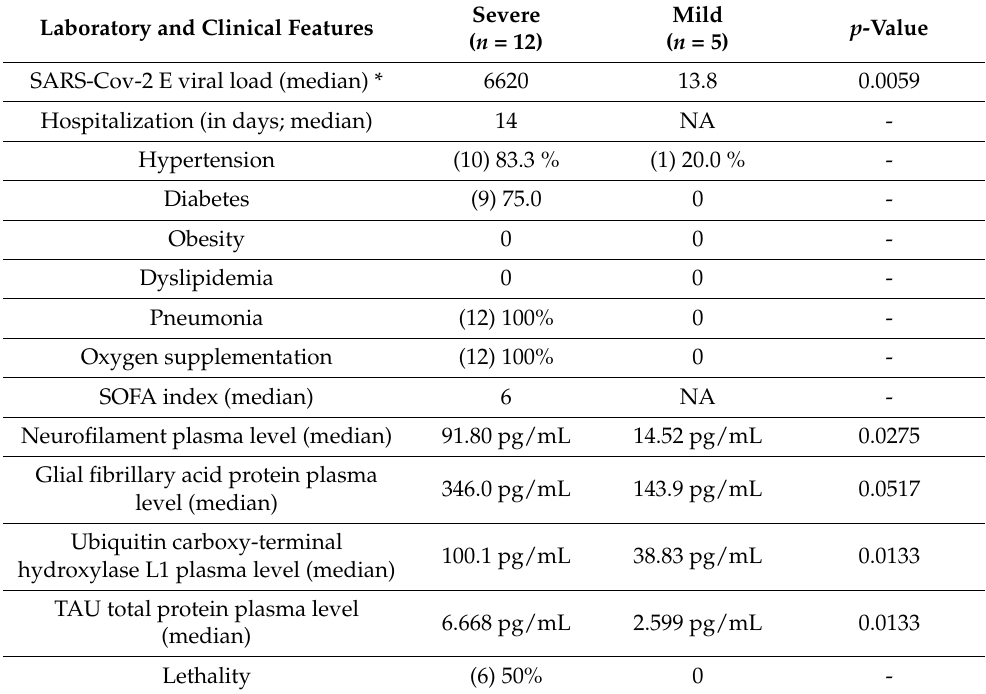
Table 1. Laboratory and clinical features. Comorbidity, viral load, and serum biomarker levels of light chain neurofilament, glial fibrillary acid protein, ubiquitin, and TAU total protein among COVID-19 severe and mild